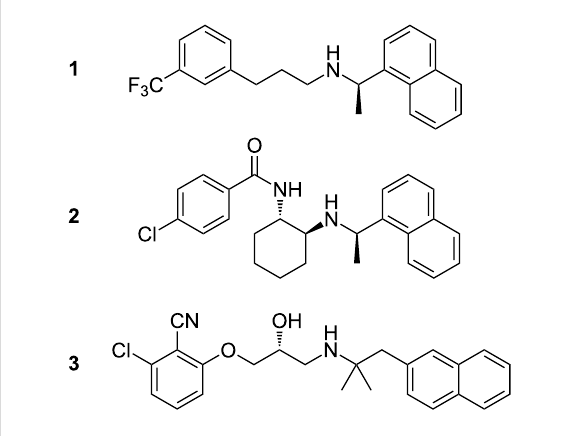
Figure 1: Marketed calcium-sensing receptor agonist cinacalcet ( 1 ), and CaSR antagonists Calhex 231 ( 2 ) and NPS 2143 (( R )- 3 ).